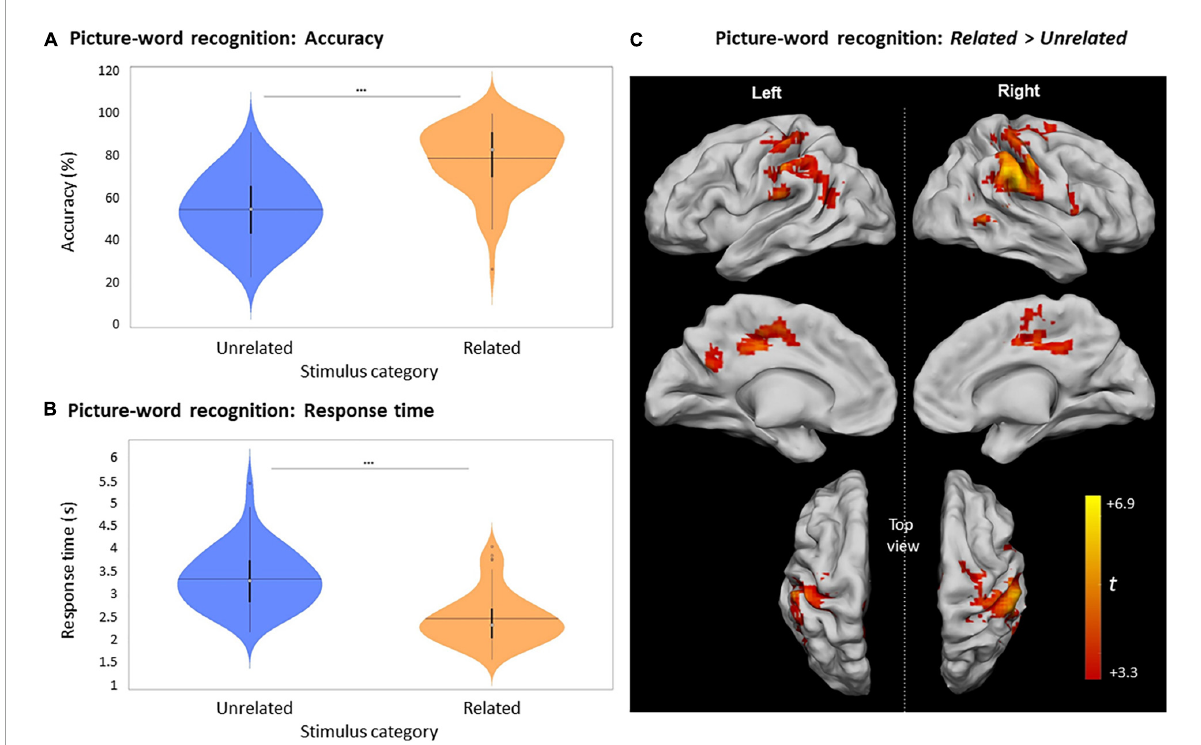
FIGURE6 Picture-word recognition according to the judgment about the relatedness of pairs at encoding . (A) Violin plots of recognition accuracy for picture-word pairs depending on their relatedness during encoding (i.e., Unrelated or Related ) [***: p < 0.001, horizontal black line indicates the mean, thick vertical black bars are a box plot, center white circles represent the median]. (B) Violin plots of response times for picture-word pairs depending on their relatedness during encoding [notations as in panel (A) ]. (C) Clusters with significant activity during picture-word recognition for Related > Unrelated, p < 0.05 FWE-cluster corrected, cluster-forming threshold = 84 voxels (at p < 0.001, uncorr.).